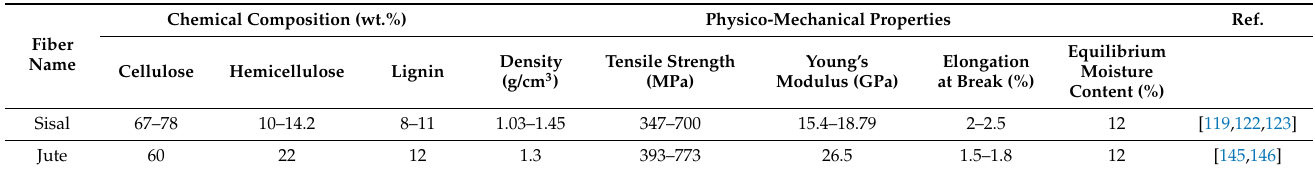
Table 3. Chemical composition and properties of cellulosic